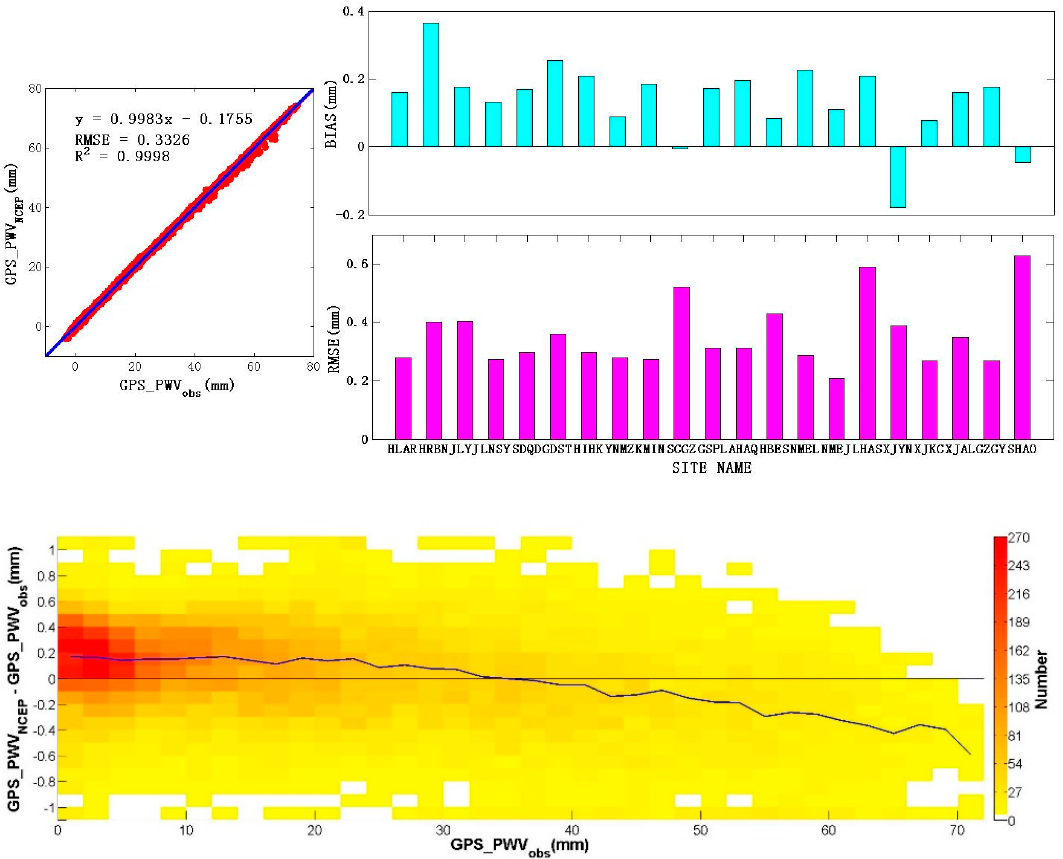
Figure 10. Scatter plot ( top left ), BIAS, and RMSE at each GPS station ( top right ); and number density plot of differences ( bottom ) between GPS_PWV obs and GPS_PWV NCEP .